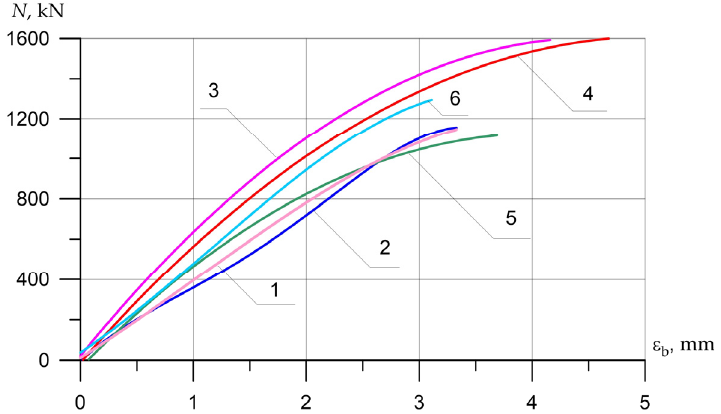
e = 0. The e = 0. The 0 0